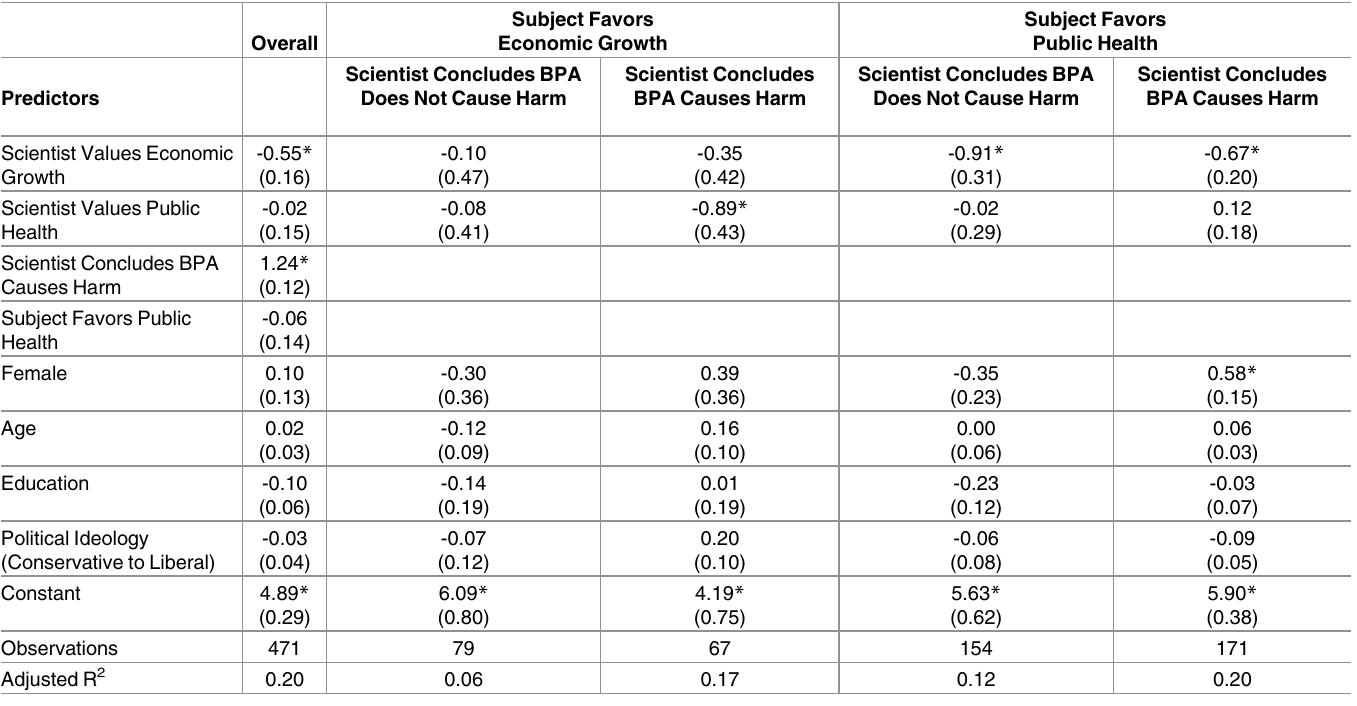
Table 3. Measuresof the effect of scientists’ policy recommendations and expressedvalues on respondents’ positive attitude toward them (Experiment 2).